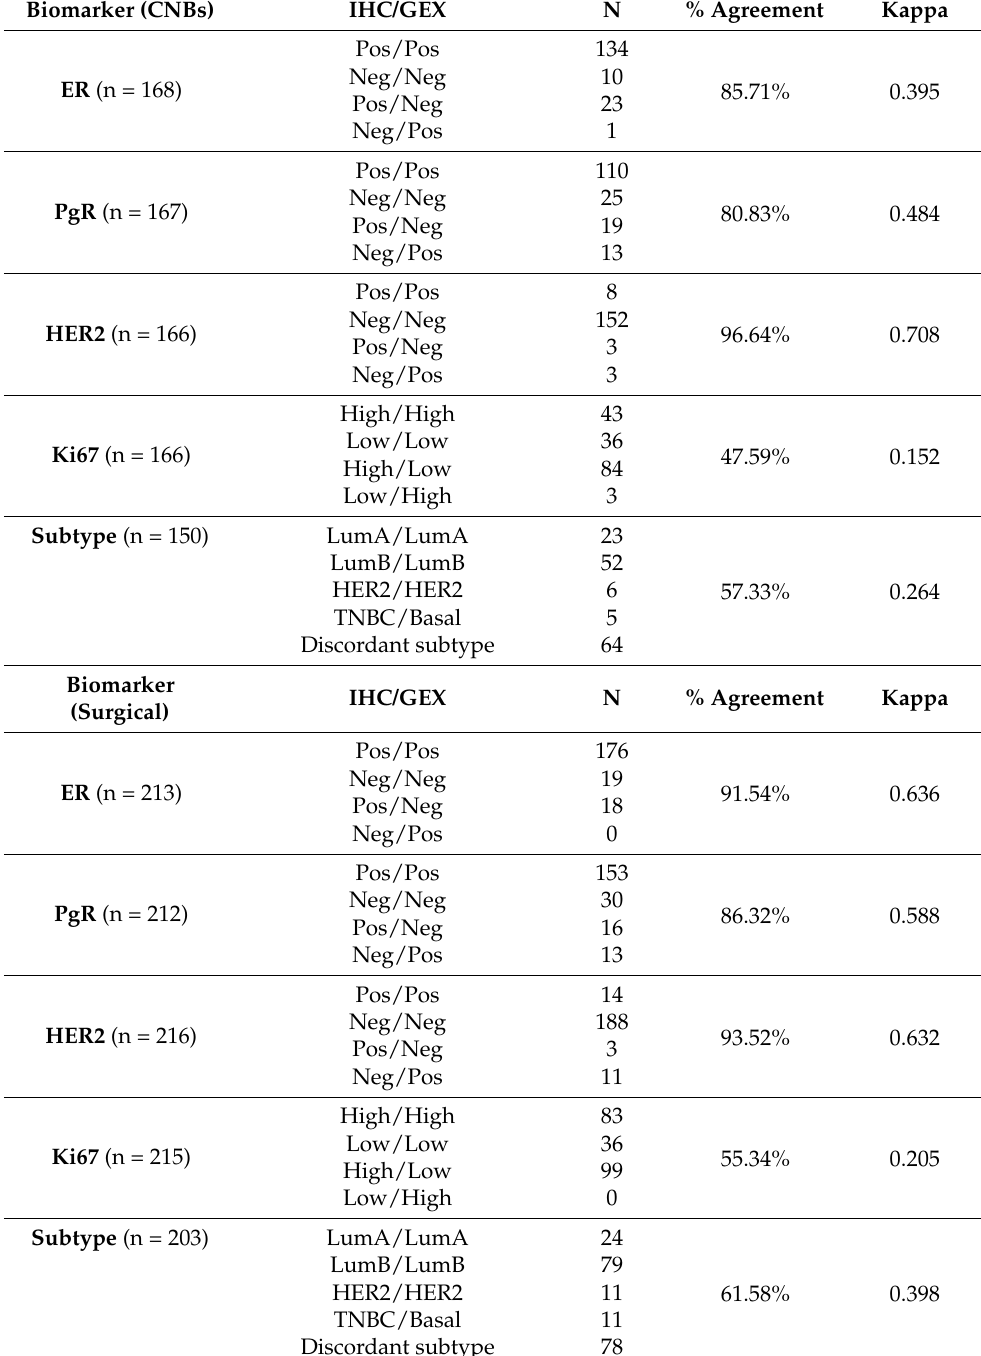
Table 3. Concordance of biomarker status assessed by IHC compared to GEX for CNBs and surgical specimens,